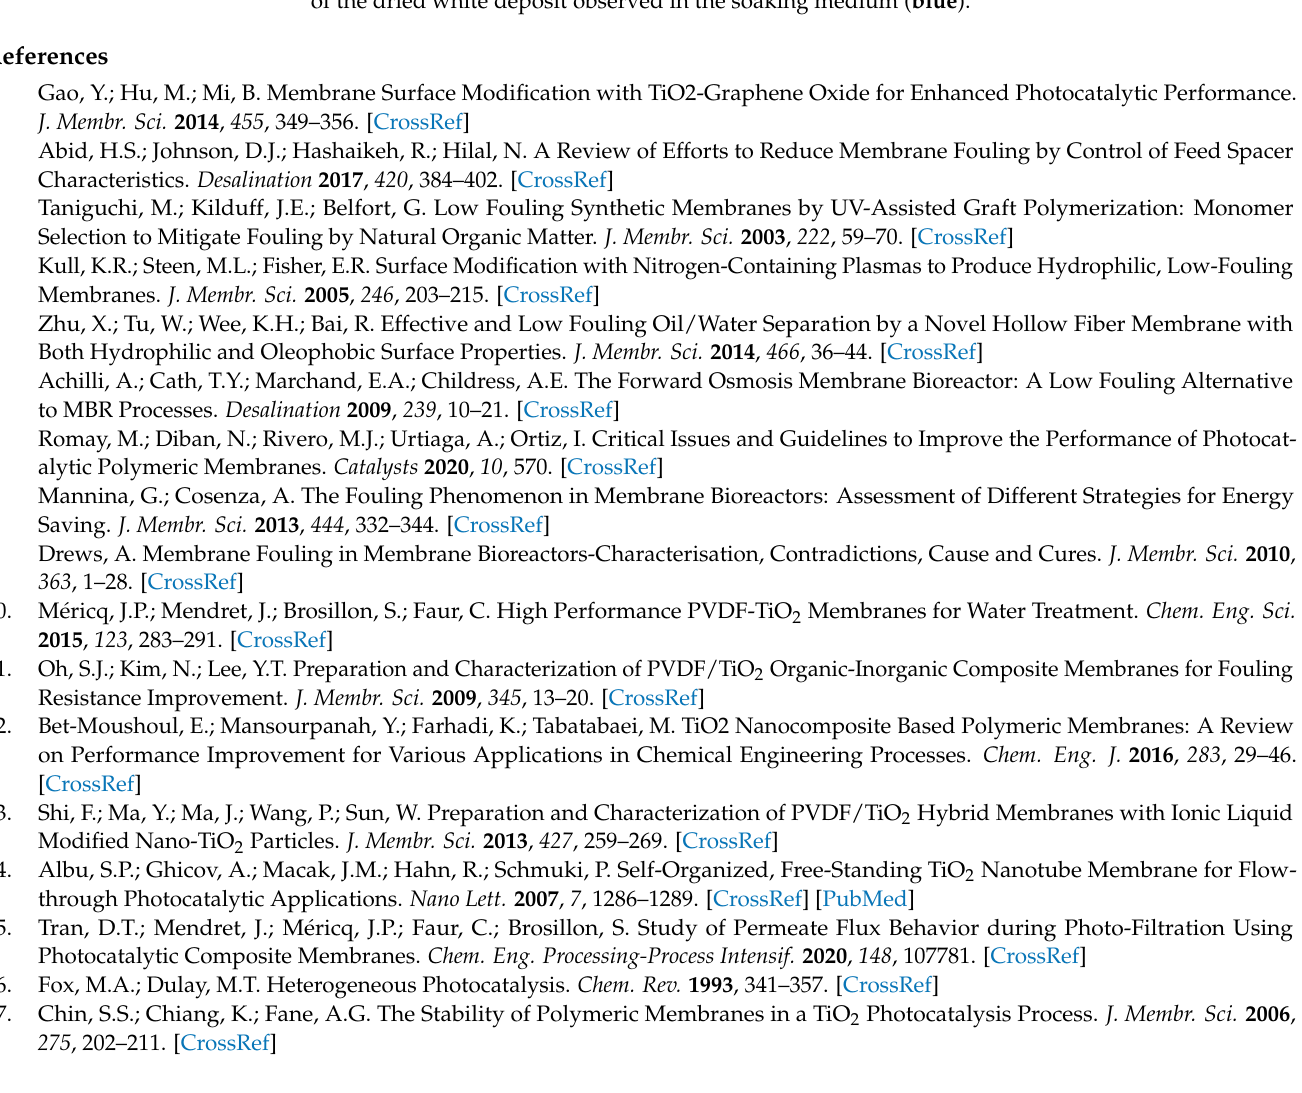
Figure A1. FTIR spectra of commercial TiO 2 used in the production of the membrane ( orange ) and of the dried white deposit observed in the soaking medium ( blue ).